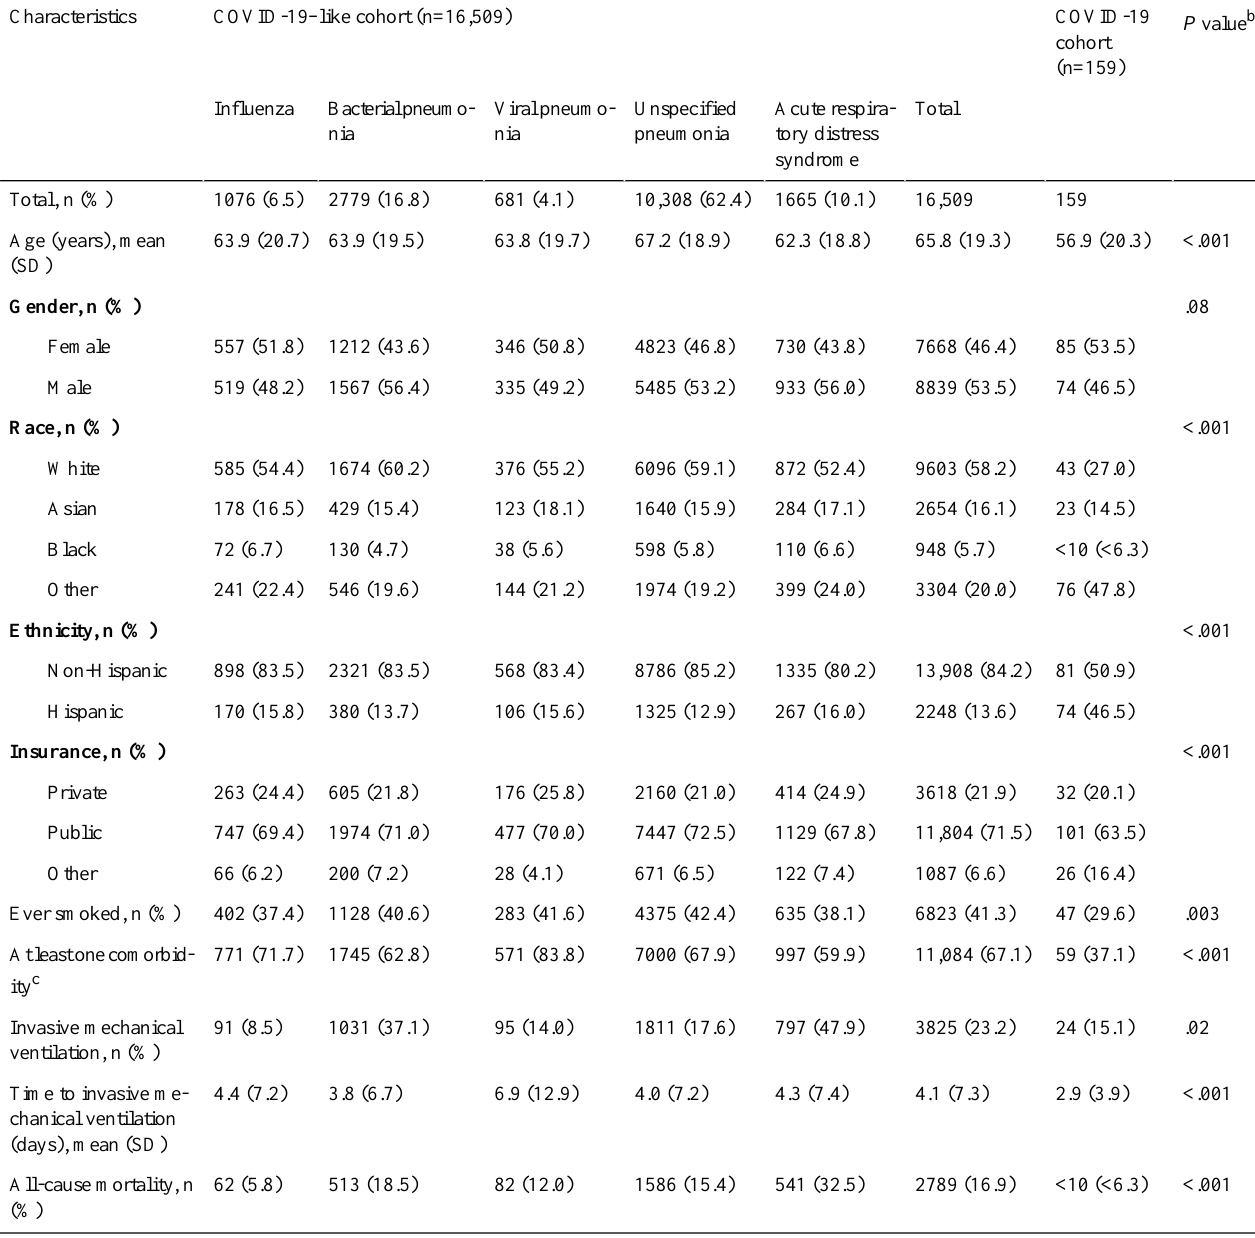
Table 1. Comparison of patient demographics in COVID-19–like and COVID-19 cohorts a . (n=159)COVID-19–like cohort